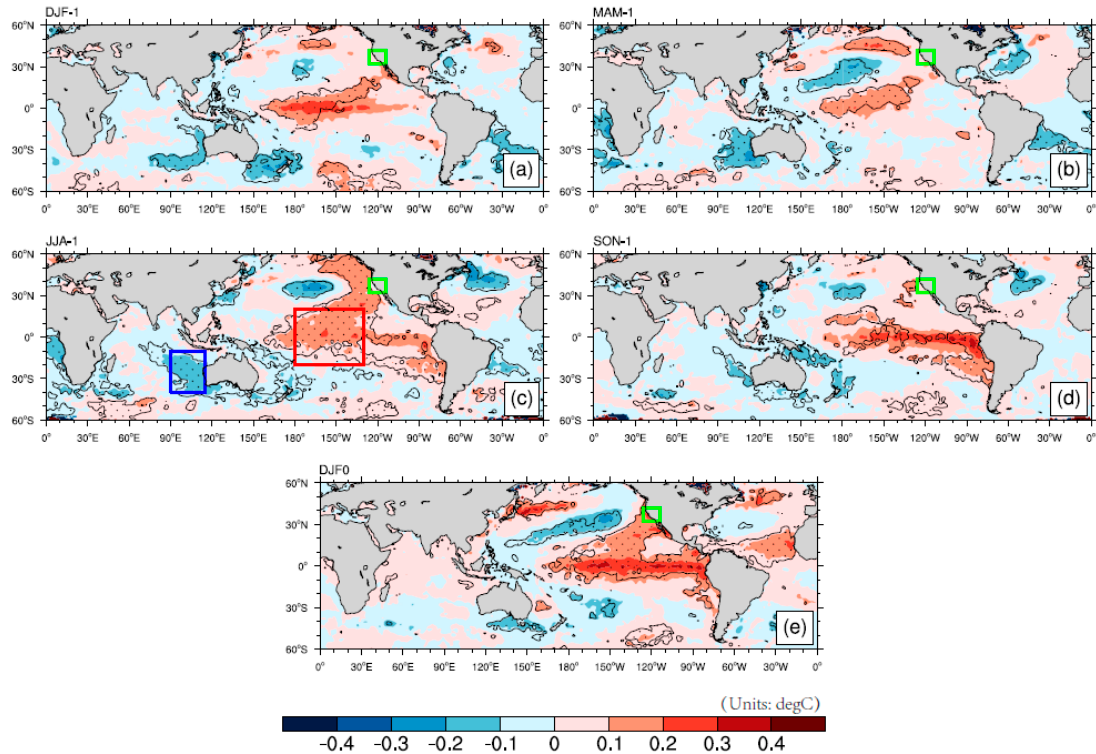
Figure 3. Evolution of SST patterns (°C) regressed to standardized PC1 from the preceding winter ( a ) to spring ( b ), summer ( c ), autumn ( d ) and the subsequent winter ( e ). Areas with dots exceed a 90% confidence level. The green box represents the selected California area. Red and blue boxes denote key regions analyzed.